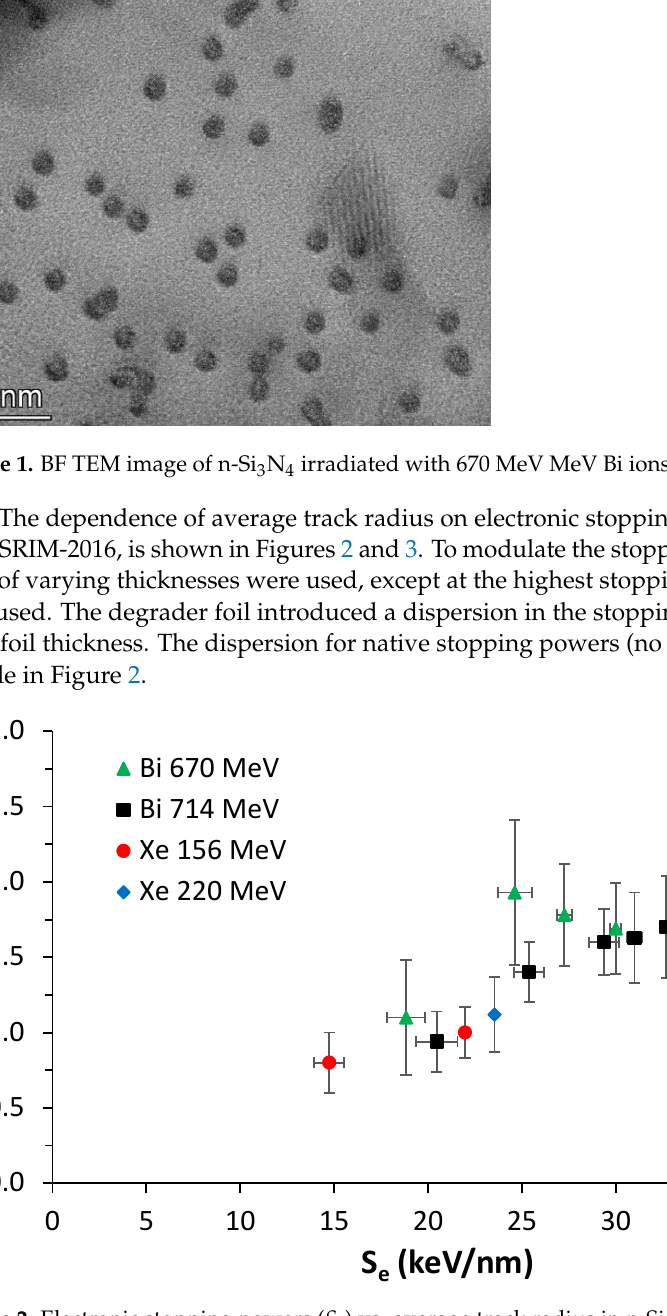
Figure 2. Electronic stopping powers ( S e ) vs. average track radius in n-Si 3 N 4 . The highest stopping power where no tracks were observed was 16.5 ± 1.2 keV/nm (714 MeV Bi with 27.7 μm Al degrader). At a stopping power of 14.5 ± 1.1 keV/nm (670 MeV Bi with 28.1 μm Al degrader) , ion tracks were not continuous – amorphous, as was the case for all other observed ion tracks, but consisted of defect structures within the crystal. At a stopping power of 14.7 keV/nm (156 MeV Xe with 8 μm Al degrader) , tracks were only observed in small nanoparticles (diameter < 30 nm) or on the edges of larger nanoparticles. Table 1 provides a summary of these stopping powers, where tracks were either not observed or in a different state, or observed only in special cases. Taking the average value of the highest stopping powers where tracks were observed as either de- fectstructures or only on the edges of large particles and small particles or not observed (i.e., 14.7, 14.5, and 16.5 keV/nm as per the last three values in Table 1), we obtained an upper bound of 15.2 ± 1.0 keV/nm. Then, we took the lower bound as the lowest stopping power where tracks were not observed, i.e., 12.3 ± 0.8 keV/nm. This suggests that the threshold stopping power for track formation lies somewhere within the bounds of 12.3 ± 0.8 < S et < 15.2 ± 1.0 keV/nm. Table 1. Summary of stopping powers where tracks are not formed, not amorphous, or only ob- served in special cases. Ion/Energy (MeV)